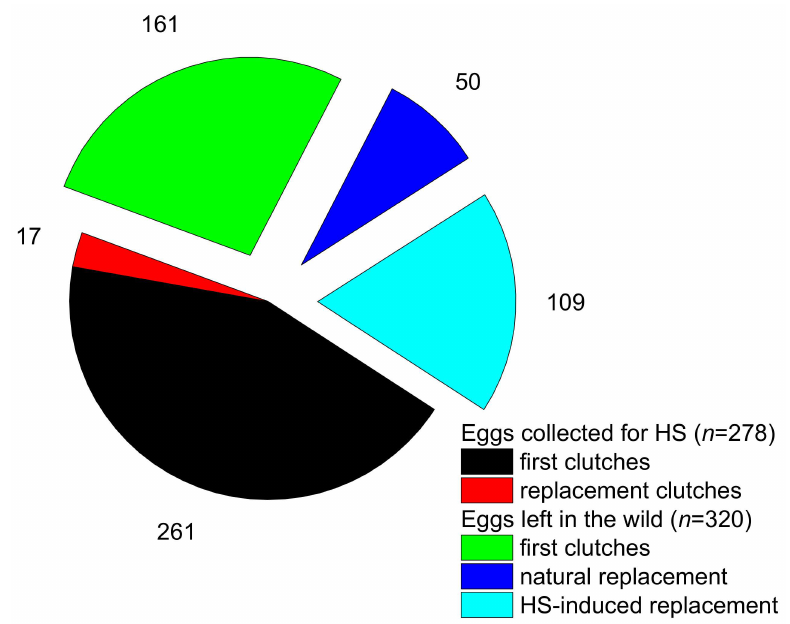
Figure 2. The fate of eggs found in the study area in the vicinity of Meinypil’gyno in 2012–2022 ( n = 598).